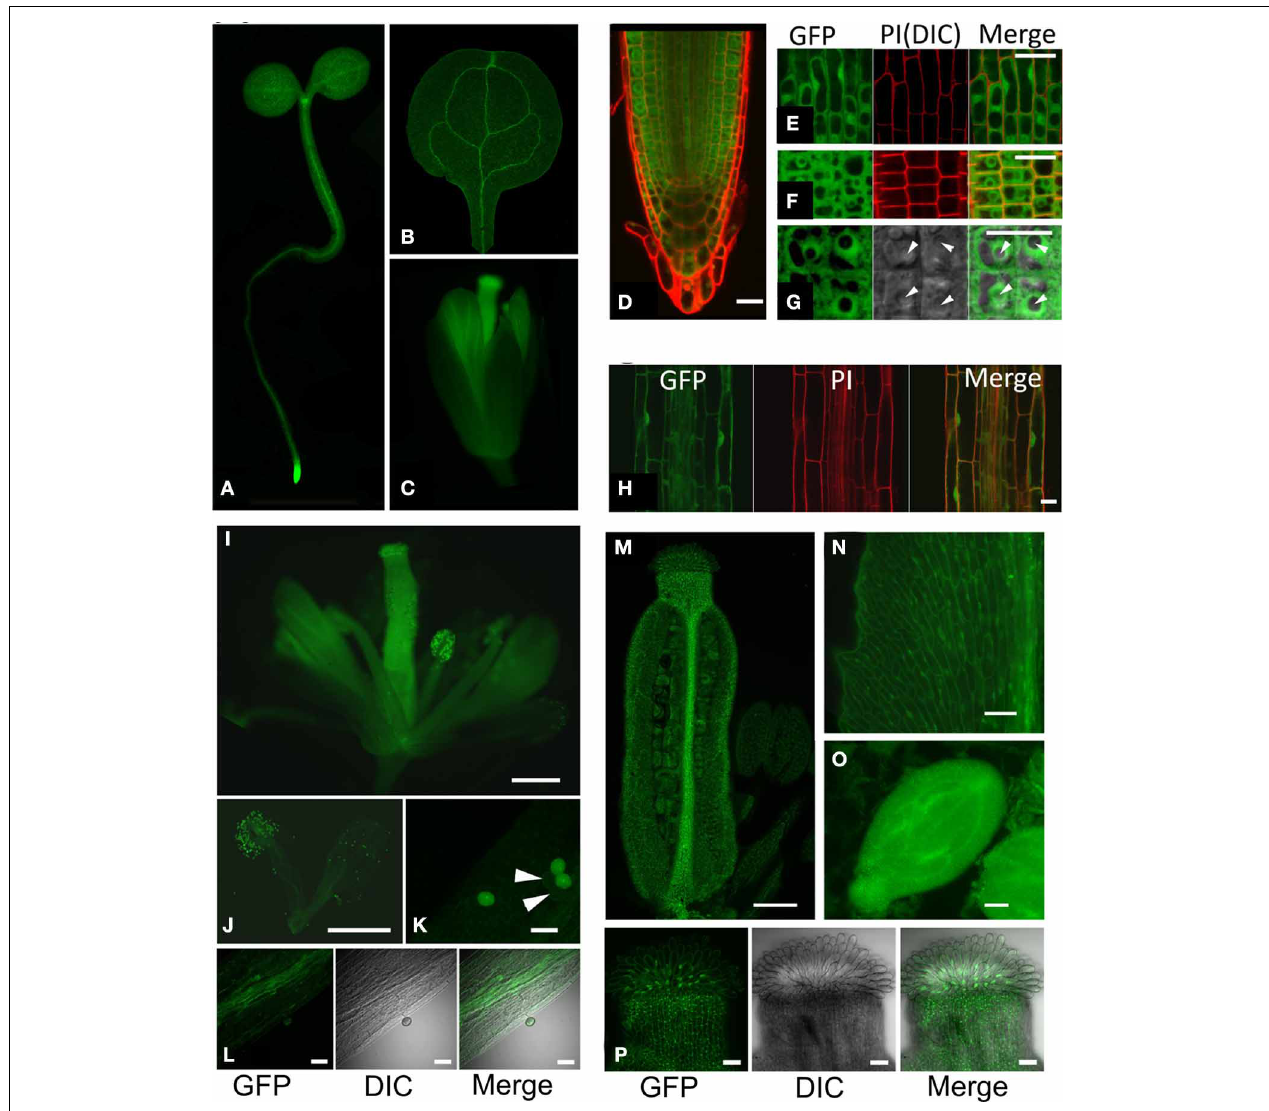
FIGURE 4 | GSNOR is expressed in various organs and developmental stages in Arabidopsis. Localization of GSNOR was observed in plants transformed with GSNOR::GSNOR-GFP in the hot5-2 background. All plants were homozygous for the GSNOR::GSNOR-GFP transgene, with the exception of those used for images in (I–K) . (A) Whole seedling. (B) Cotyledon. (C) Flower, stage 13. (D) GSNOR-GFP distribution and localization in root tip cells in optical cross section through the middle of the root. (E) GSNOR-GFP localization in root epidermal cells. (F, G) Optical cross section of GSNOR-GFP localization in root cortex cells at two